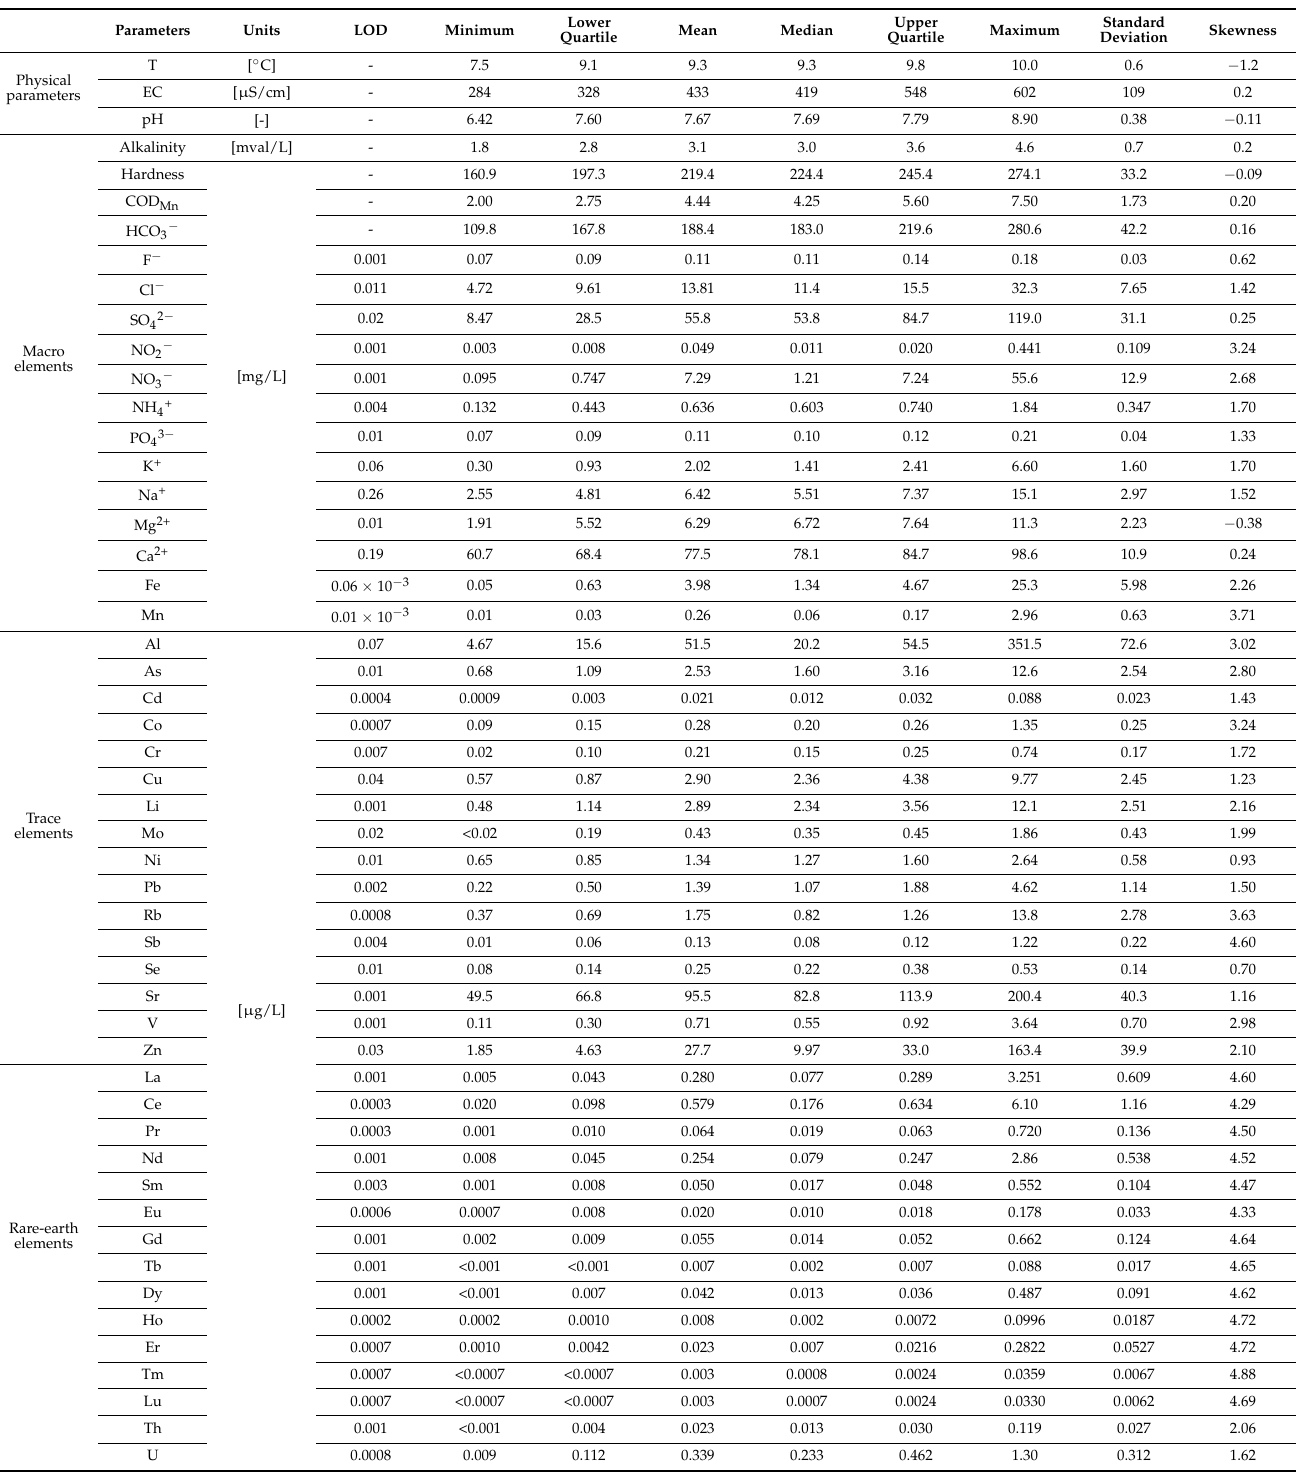
Table 1. The values of descriptive statistics for physical parameters and the concentrations of macro elements, micro elements and rare-earth elements in spring